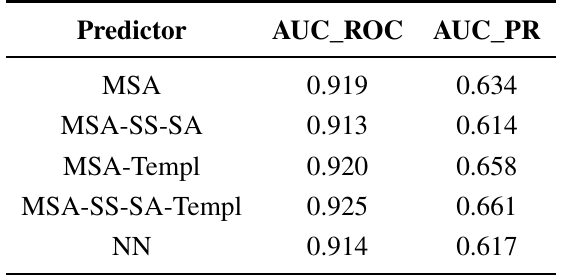
Table 3. Results of AUC_ROC and AUC_PR on the test set for all